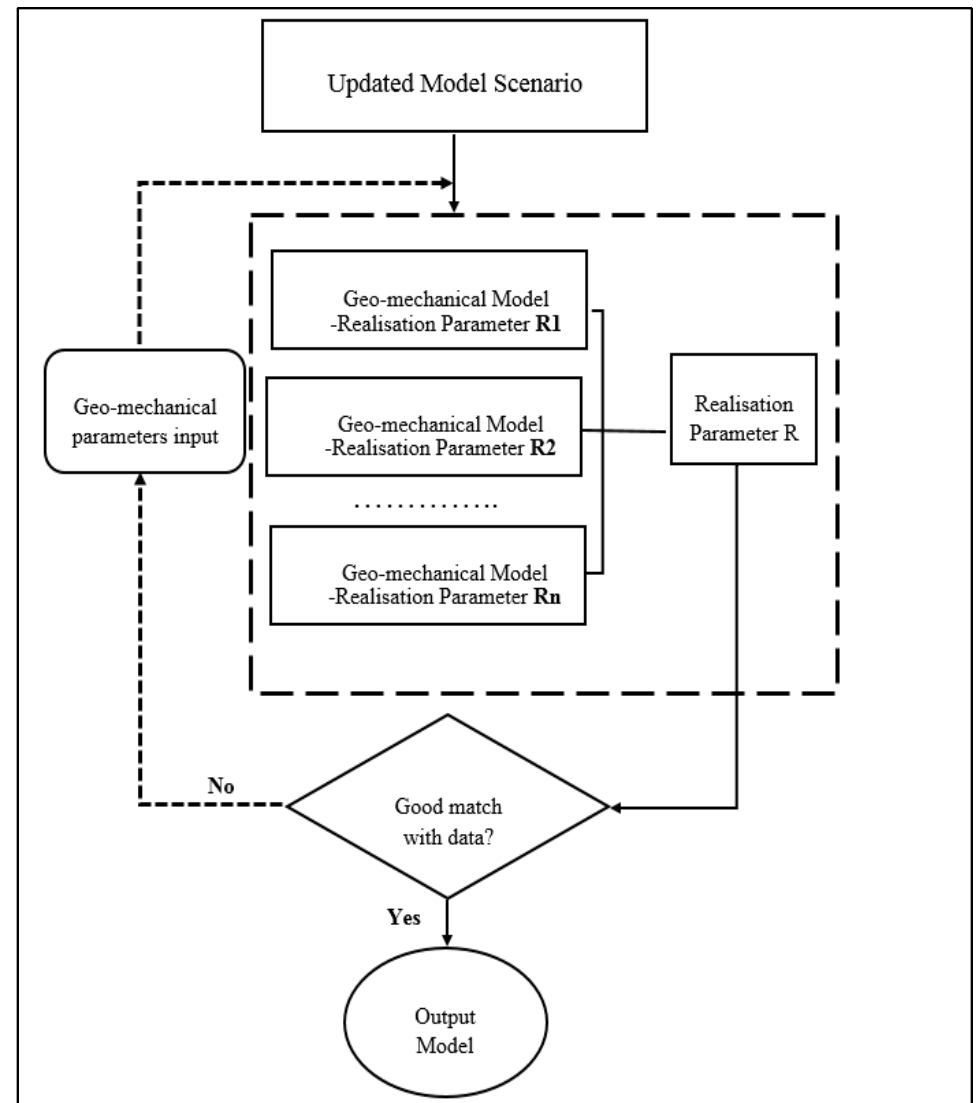
Figure 33. History matching workflow with TIF modelling.